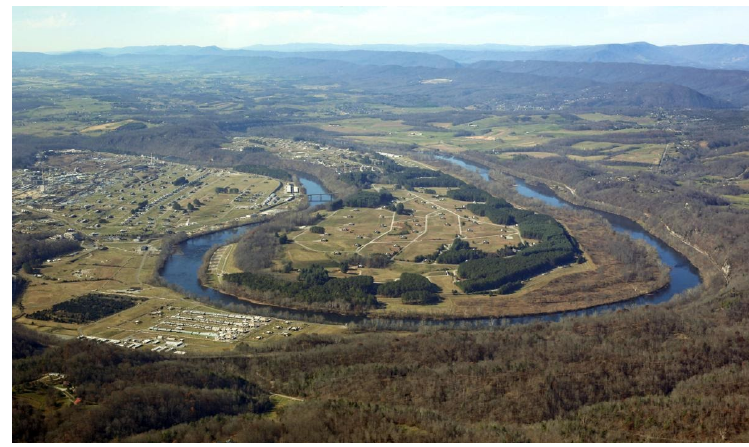
Figure 3. Aerial Image of Radford Army Ammunition Plant, 2006. Photo by Steve DeHart.